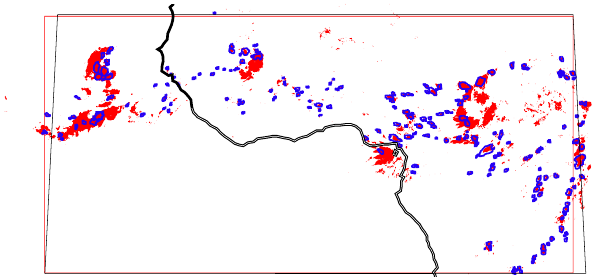
Figure 5. An example of the comparison between RDT areas (blue outlines) and the high IWC mask (red). RDT and the high IWC mask were taken on 7 September 2009 13:15:00UTC. The black and red boxes are for visualization purposes